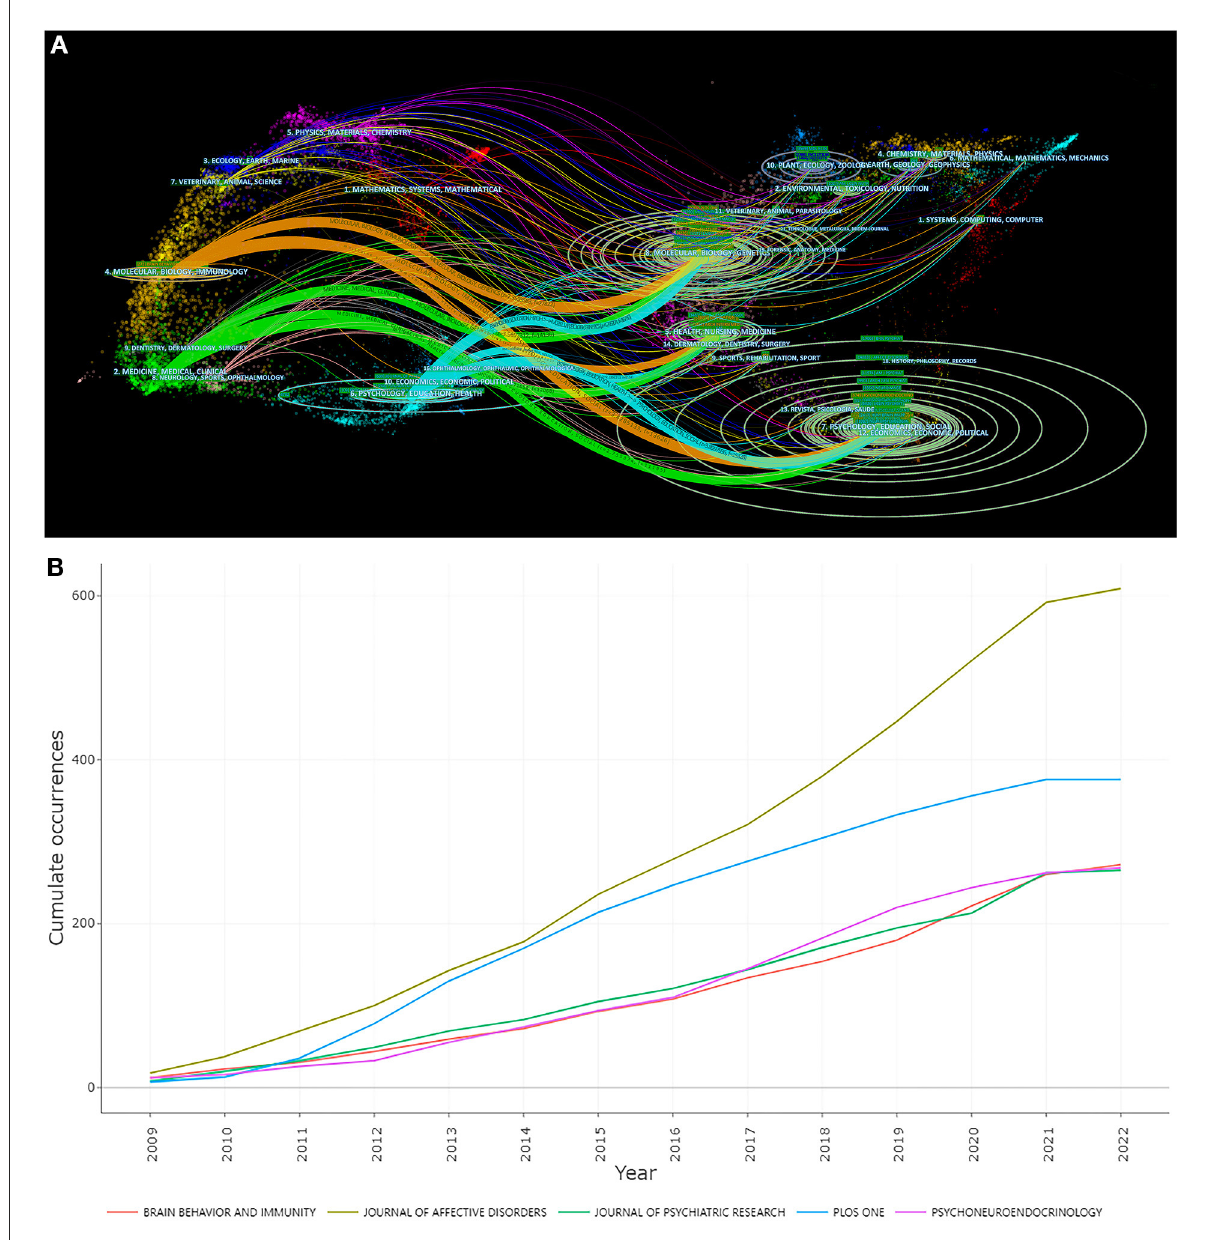
FIGURE4 The visualization of Core Journals. (A) Biplot overlay of article citations for depression biomarker research. (B) Source dynamics of top 5 Core